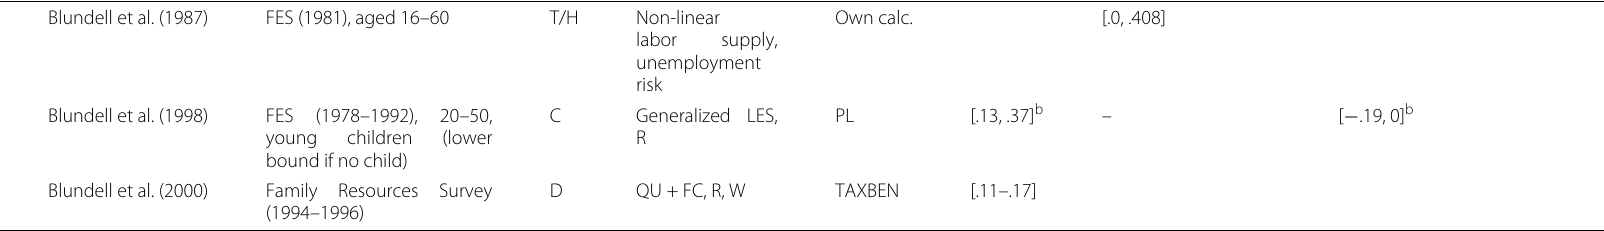
Table 1 Labor supply elasticities in Europe: couples (Continued) Blundell et al. (1987) FES (1981), aged 16–60 T/H Non-linear Own calc. [.0, .408] labor supply, unemployment risk Blundell et al. (1998) FES (1978–1992), 20–50, C Generalized LES, PL [.13, .37] b – [ − .19, 0] b young children (lower R bound if no child) Blundell et al. (2000) Family Resources Survey D QU + FC, R, W TAXBEN (1994–1996)